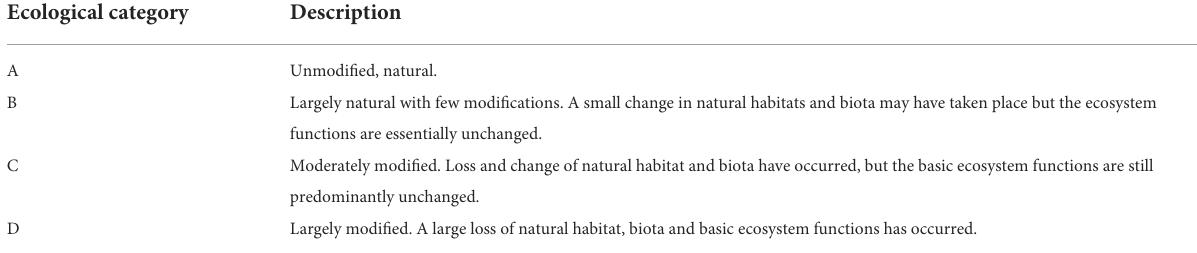
TABLE 1 Ecological categories as defined by the South African Ecostatus suite of models Kleynhans and Louw (2008). Ecological